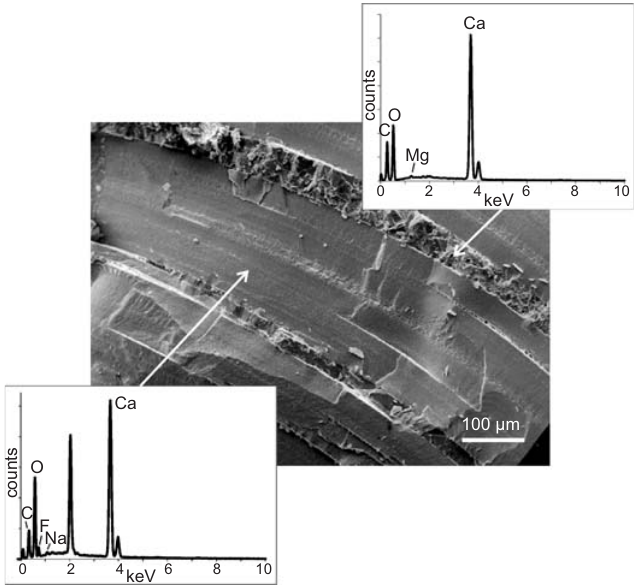
Fig. 6. EDS spectra of the phosphatic Sphenothallus tube with diagenetic calcite interlayer. Scale bar 100 μ m.